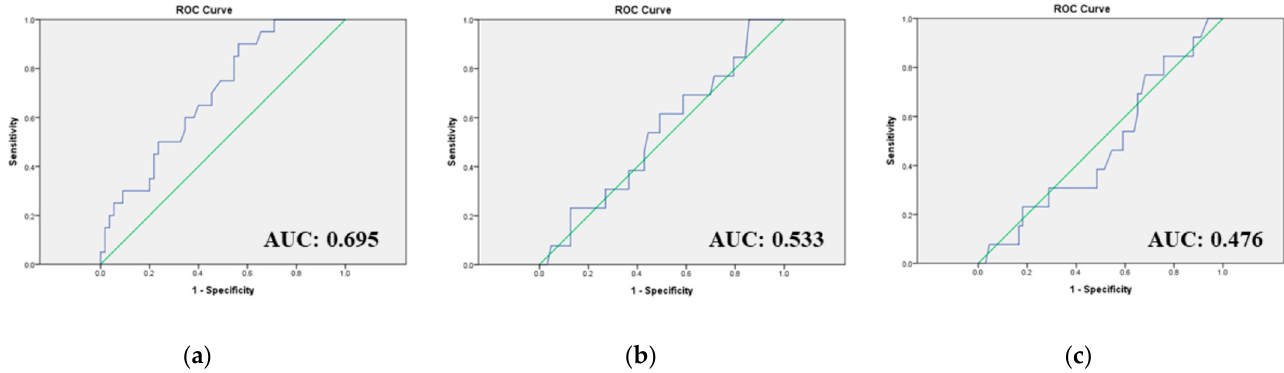
Figure 1. The receiver operating characteristic (ROC) curve analyzing the accumulative BEV dose and presence of BEV-related toxicities. ( a ) The accumulative BEV dose and the BEV-related changes in blood pressure. ( b ) The accumulative BEV dose and the BEV-related “De novo” proteinuria. ( c ) The accumulative BEV dose and other BEV-related toxicities (including GIP, TE/bleeding, wound, and IAI). BEV, bevacizumab; GIP, gastrointestinal perforation; TE, thromboembolism